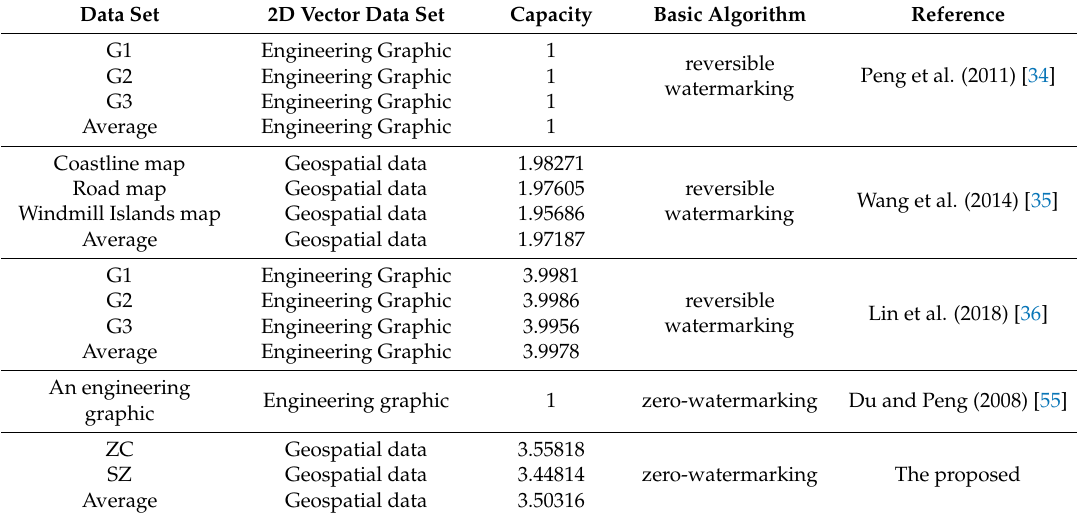
Table 3. Watermark capacity of different methods